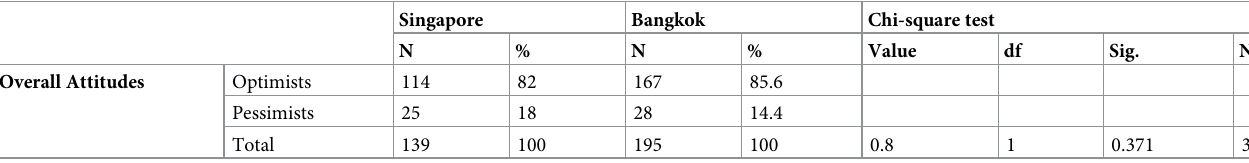
Table 4. A comparison of optimists and pessimists by